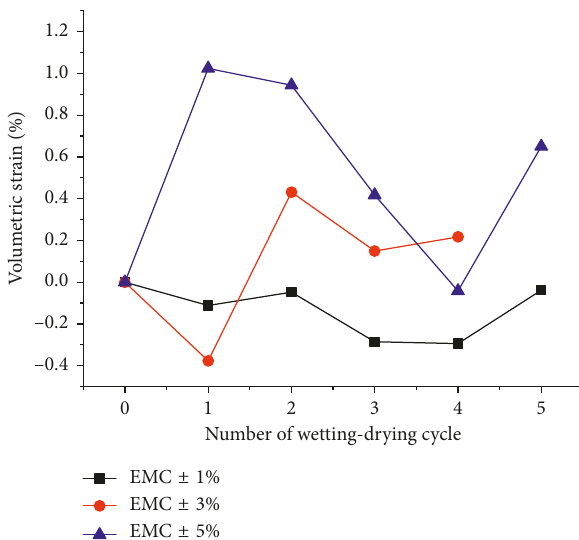
Figure 15: Variations of volumetric strain with wetting-drying